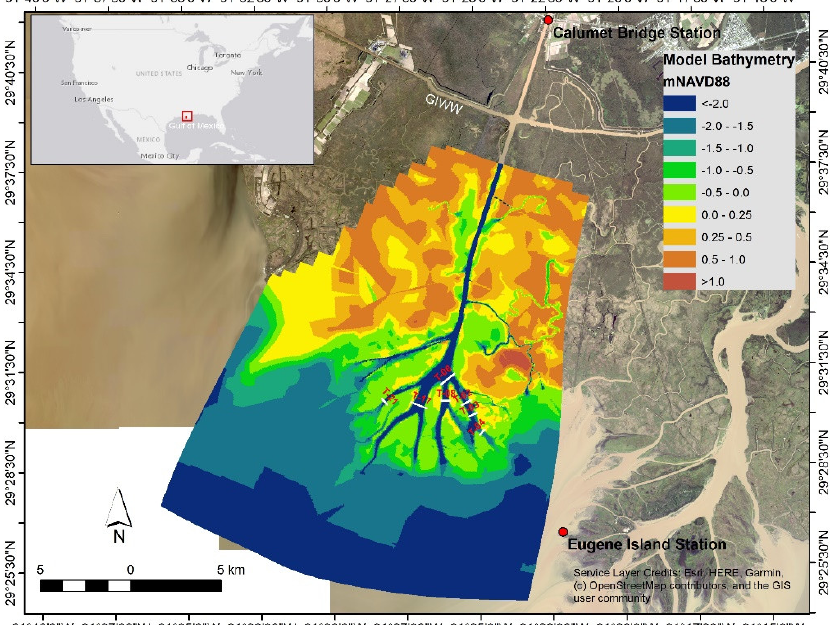
Figure 1. Map of the study area. Red dots show the stations used to prescribe the model boundary conditions, and the white lines represent transect locations where field measurement were made.